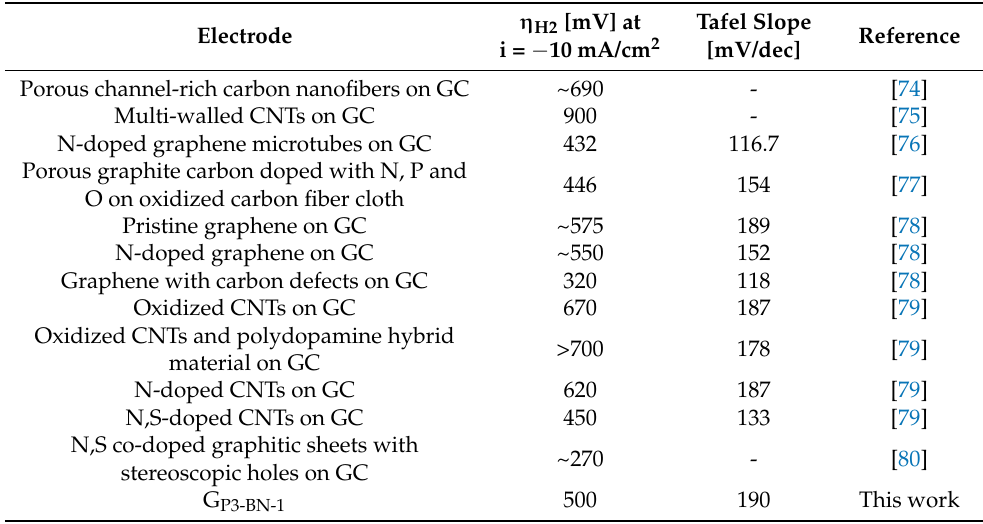
Table 2. Comparison of the HER electrochemical activity ( η H2 and Tafel slope values) of the G P3-BN-1 electrode in 1 M KOH electrolyte solution with that of other metal-free electrodes reported in the last